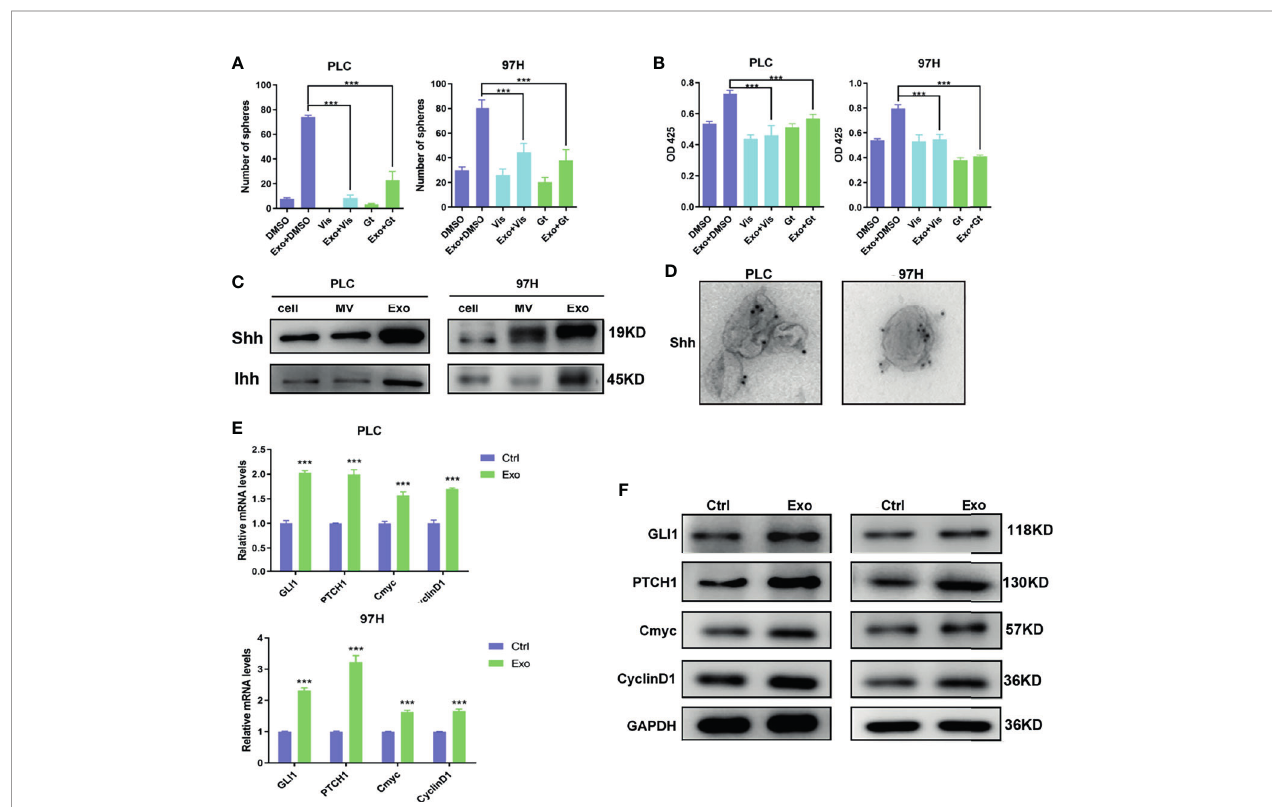
FIGURE 3 | The role of Shh and hedgehog signaling pathway in promoting cell growth. The effect of hedgehog inhibitors on the stimulating effect of Exo (10 m g/ml) on (A) sphere formation and (B) cell proliferation. The inhibitors were added at the concentrations of 5 m M for GANT61 or 10 m M for Vismodegib. (C) The expressions of hedgehog ligands in PLC/PRF/5 and MHCC-97H as analyzed by Western blot. (D) Electron microscope image of immunogold staining of Shh on MV and Exo of PLC/PRF/5 and MHCC-97H. (E) Quantitative PCR analysis of the mRNA levels, and (F) Western blot analysis of the protein levels of hedgehog signaling pathway target genes in PLC/PRF/5 and MHCC-97H cells cultured with and without exosomes (10 m g/ml) isolated from the culture medium of the same cell line. The data are presented as an average of three biological replicates. *** p <